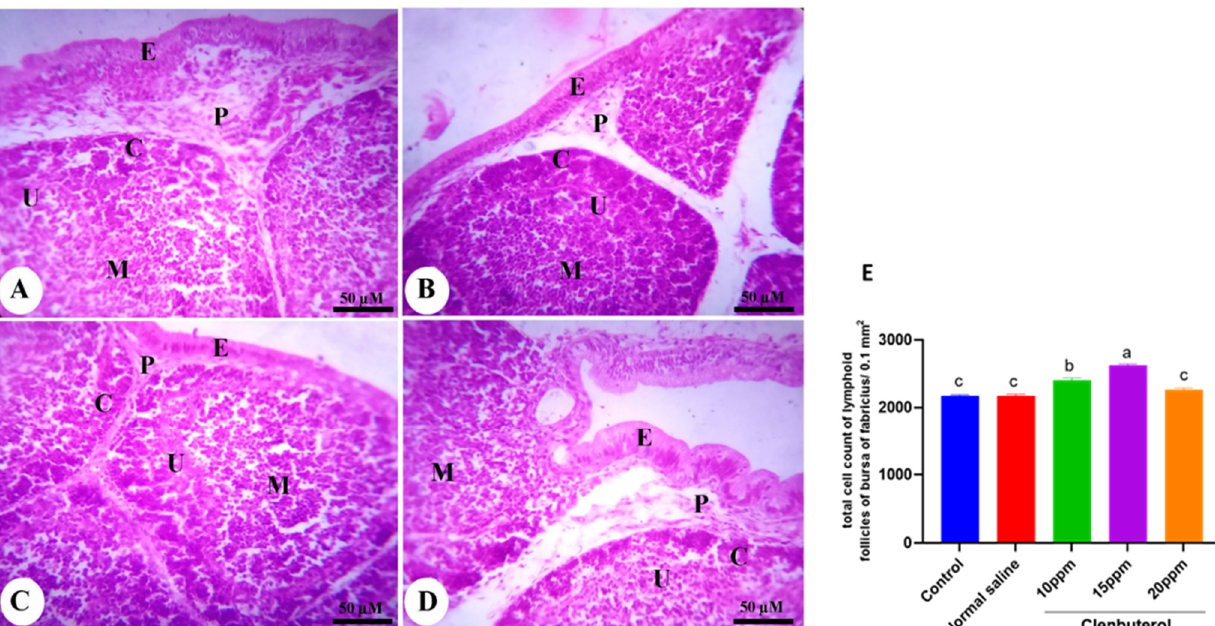
Figure 5. Photomicrograph of the bursa of Fabricius of control ( A ) and clenbuterol treated groups of chickens; ( B ) clenbuterol 10 ppm, ( C ) clenbuterol 15 ppm and ( D ) clenbuterol 20 ppm showing pseudostratified columnar epithelium ( E ), lamina propria (P), cortex (C) and medulla (M) of lymphoid follicle separated by undifferentiated cell layer (U). Stain H&E, scale bar = 50 µ m. E. morphometric analysis of total cell count of lymphoid follicles of the bursa of Fabricius. Columns with differ superscripts (a, b, c, d) differ significantly ( p < 0.05)